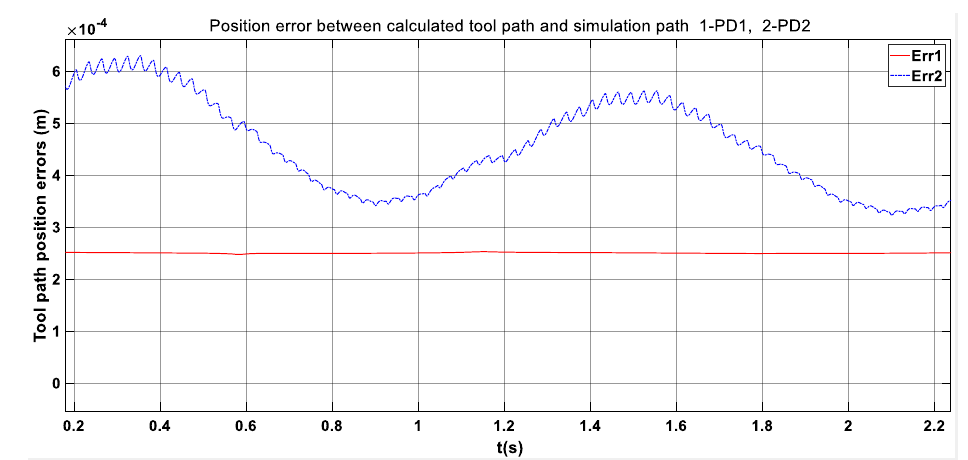
Figure 12. The errors of the cutting trajectory with respect to the set one are the toolpaths of the PD1, PD2 controllers.